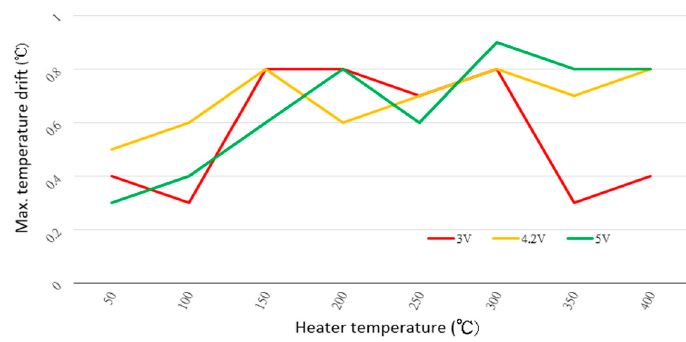
Figure 7. Maximum temperature drift of the microheater (=maximum temperature minus minimum temperature) as a function of the microheater temperature and for several power-supply voltages.